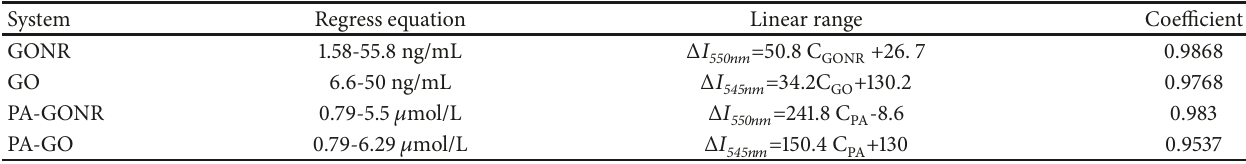
Figure 4: S EM of the analysis system. a:1.13 mol/L CH 3 CH 2 OH+ 3.14 𝜇 mol/L PA+0.193 mmol/L HAuCl 4 +3.3 mmol/L H 2 O 2 +23.8 ng/mL GONR; b:a+17.2 nmol/L Na + . Table 1: Comparing of the catalytic and inhibition characteristics by RRS method.